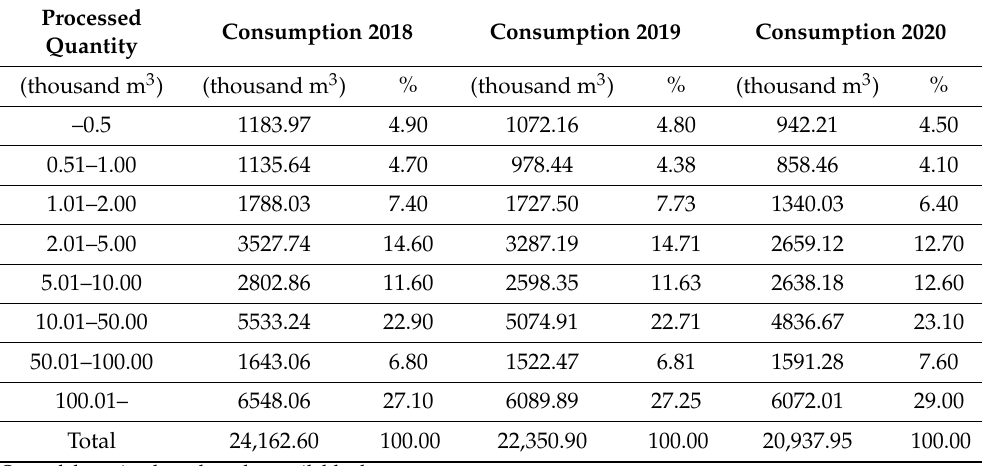
Table 4. The consumption of round wood by sawmills in Poland, depending on their processing volume.